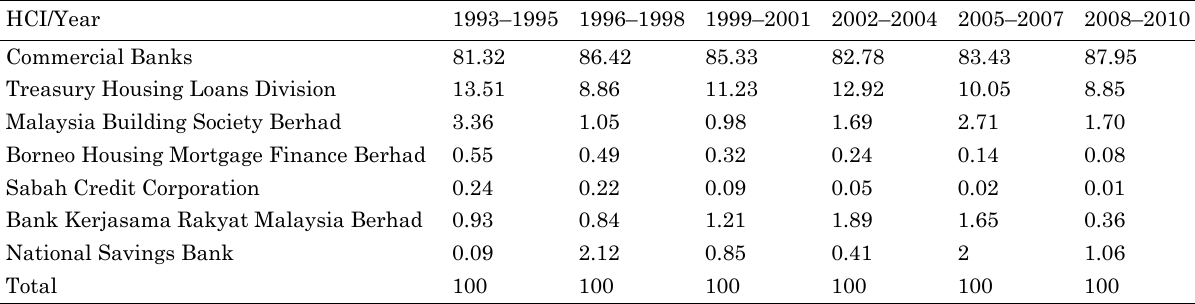
Table 1. Housing Credit Institutions (market share of approved housing loans)